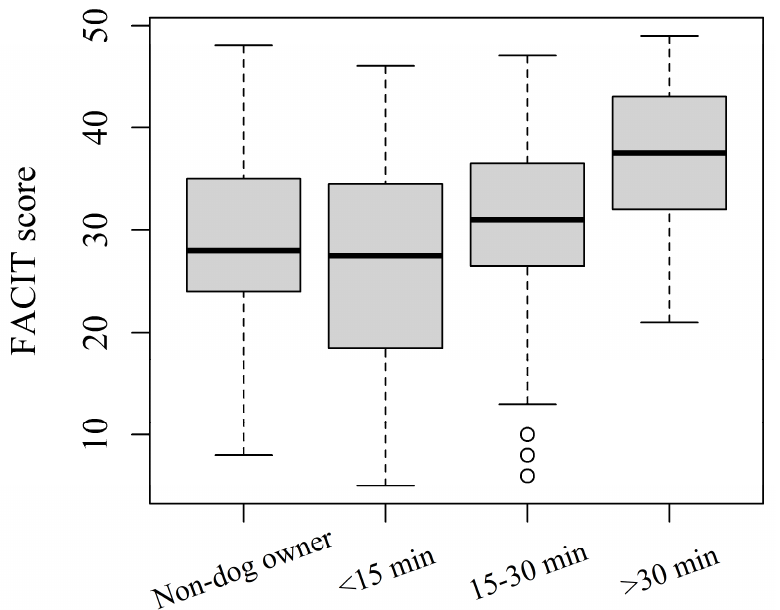
Figure 1. The distribution of FACIT score by dog ‐ walking duration. Boxplots represent the median (central line), 25th–75th percentiles (box), and min ‐ max non ‐ outlier values (whiskers). (central line), 25th–75th percentiles (box), and min-max non-outlier values